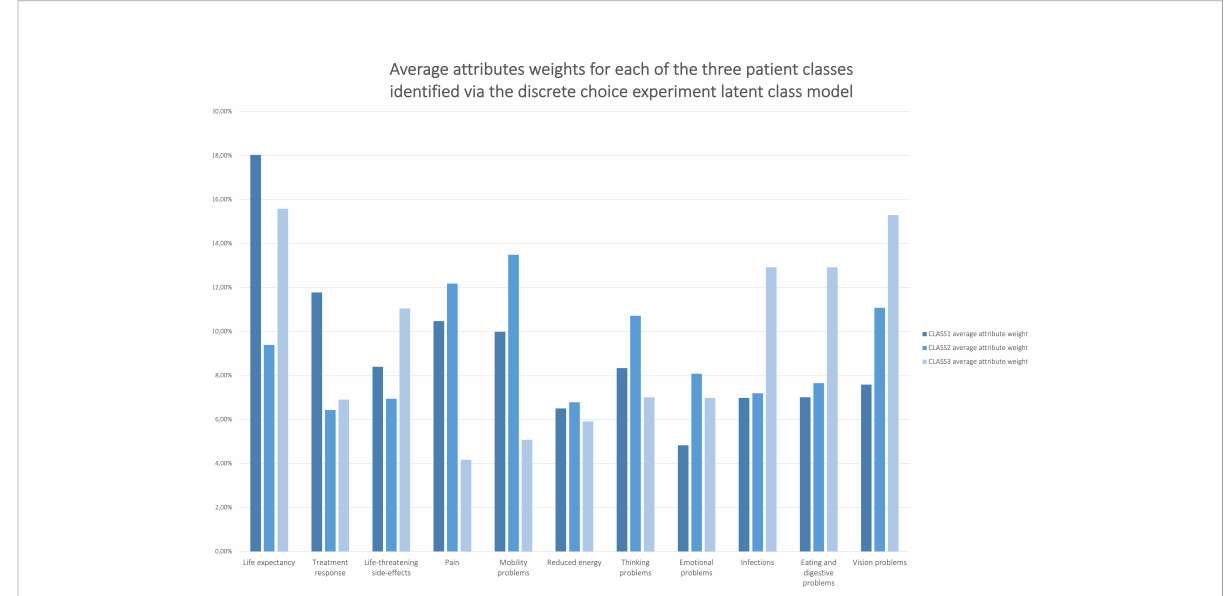
FIGURE 4 Average relative attribute importance ’ s of the attributes for each of the three patient classes identi fi ed via the DCE latent class model. Preference heterogeneity in average attribute weights was revealed between groups of patients that differed regarding their number of previous